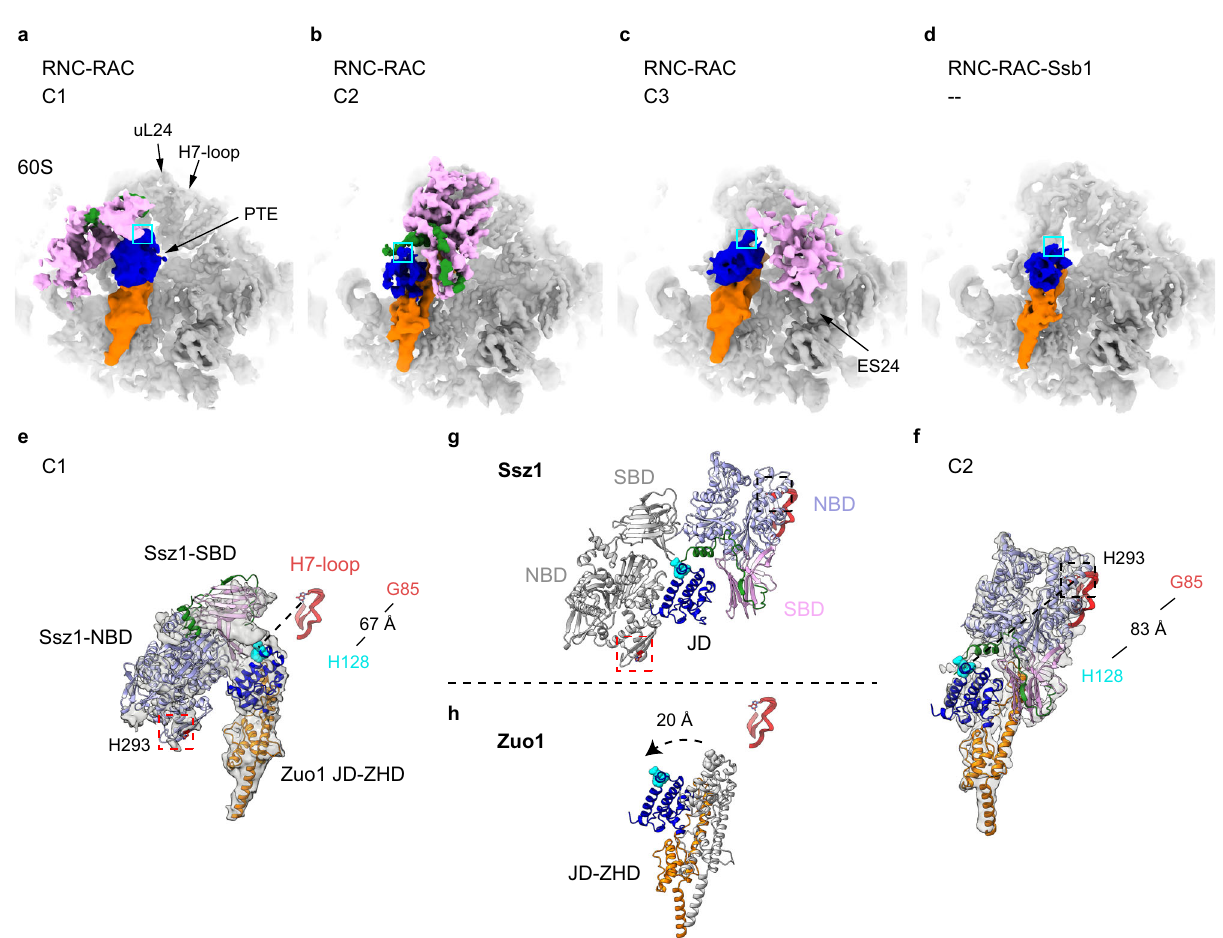
Fig. 5 Structural remodeling of RAC when engaging with the nascent chain. a – c Magni fi ed views at the PTE region of State C1-C3 from the RNC-RAC datasets (Map 3.1, Map 3.5 and Map 3.3 in Supplementary Fig. 9). The ribosome is colored gray, and Zuo1 ND, JD, ZHD and Ssz1 are shown in green, blue, orange and pink, respectively. The location of the HPD motif is labelled by a cyan box, and the PTE, uL24, H7-loop and ES24 is labeled. d Magni fi ed view at the PTE region of the structure from the RNC-RAC-Ssb1 dataset (Map 2.2 in Supplementary Fig. 6). e – h Structural transition from State C1 ( a ) to C2 ( b ). Nearly 180°-rotation of Ssz1 roughly round the HPD motif (Zuo1 JD as reference for alignment) ( g ) and rotation of Zuo1-NTD away from the PTE ( h ). Ssz1 NBD and SBD are colored lavender and pink, respectively. Models of RAC in State C1 before the transition in g – h are colored gray. The ribosome-interacting region in Ssz1 NBD-IIB is labelled by dash-line box in red (C1) or black (C2). H7-loop of the 25S rRNA is also shown as a landmark for comparison, with the nucleotide G85 in stick model. Upon the transition, the distance between G85 and the H128 of the HPD motif increases from 67 to 83